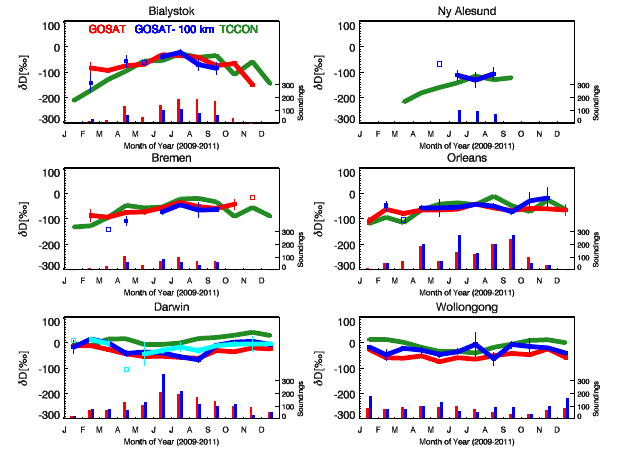
Fig. 9. Seasonal cycle in (cid:14) D retrieved from GOSAT over six TCCON sites. The figure shows the cloud-free, quality-filtered GOSAT retrievals for the time period between April 2009 and June 2011 averaged according to the month. The red line is for a spatial co-location criterion of (cid:6) 5 (cid:14) and the blue line for (cid:6) 100 km. The error bars represent the standard errors. For Darwin, we also show the retrievals for a co-locationcriteriaof (cid:6) 50km(cyanline). TCCONretrievalsareshowningreen. Thebarsatthebottomshowthenumberofdatapointsper month (numbers have been multiplied by 10 for the 100 km co-location criterion).